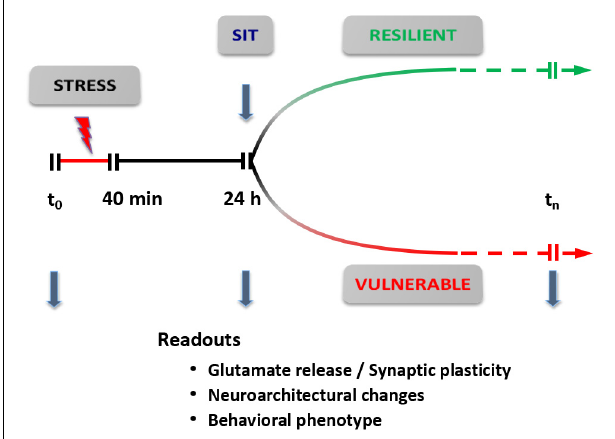
FIGURE 5 | Dynamic dissection of the acute stress response. Conceptual framework for the use of inescapable acute stress (FS stress protocol) to identify different trajectories of resilient versus vulnerable stress response. The readouts are assessed 24 h after start of the stress protocol (40 min). Readouts used are: (i) synaptic plasticity and/or transmission [spontaneous and evoked release of glutamate; spontaneous and evoked excitatory transmission; synaptic plasticity, long-term potentiation (LTP), and/or long-term depression (LTD)]; (ii) neuroarchitectural changes (length and branching of apical dendrites; number of spine synapses); and (iii) behavioral phenotype (SI test for anhedonia; cognitive tests). SIT, sucrose intake test. Modified from Musazzi et al.